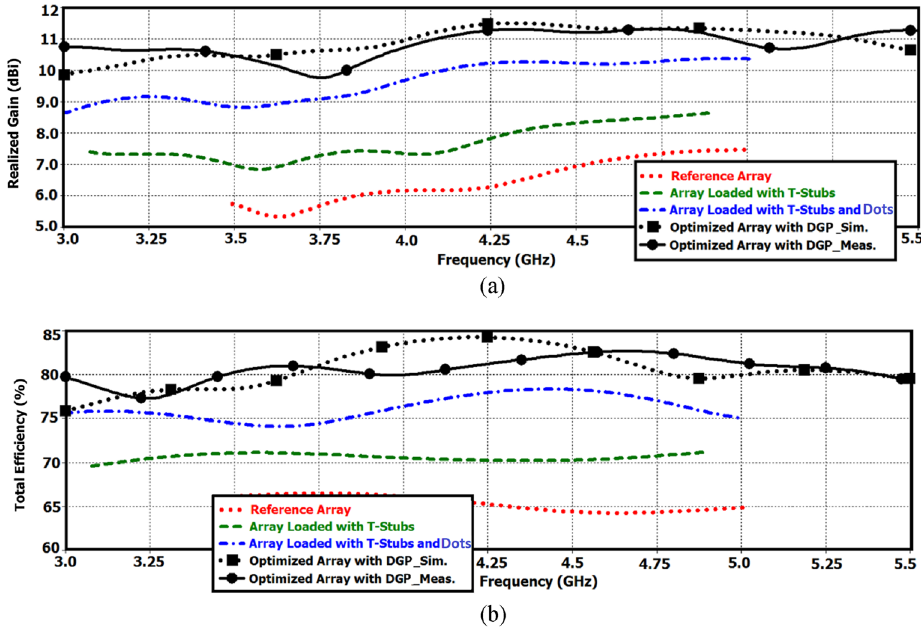
Figure 14. Radiation properties of the proposed 4-element antenna array, ( a ) realized gain, and ( b ) total efficiency.